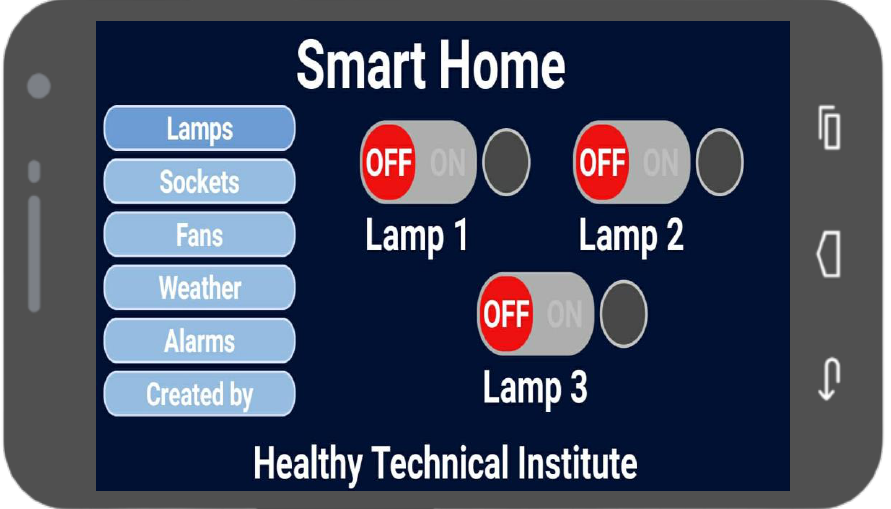
Figure 4. The graphical user interface used to control the operation of lighting and sockets. Table 2. The main components used to control the operation of lighting and